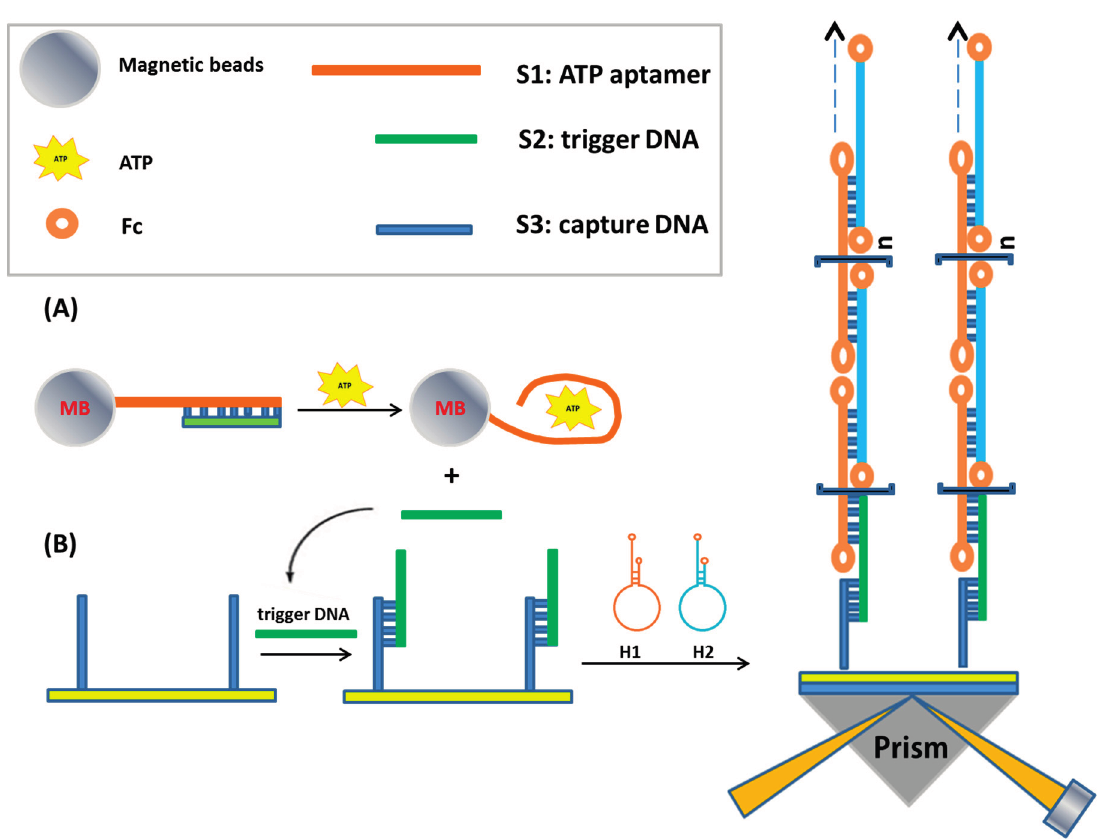
Figure 10. SPR assay for ATP detection amplified by DNA-based